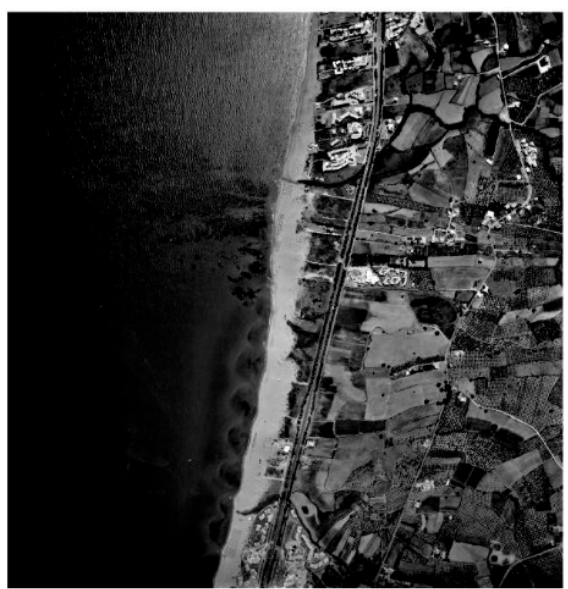
Figure 2. Application of the anisotropic diffusion into the filtered image.